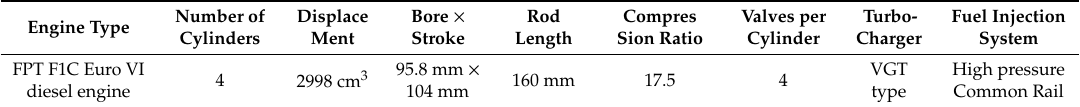
Table 1. Main technical specifications of the FPT F1C 3.0 L diesel